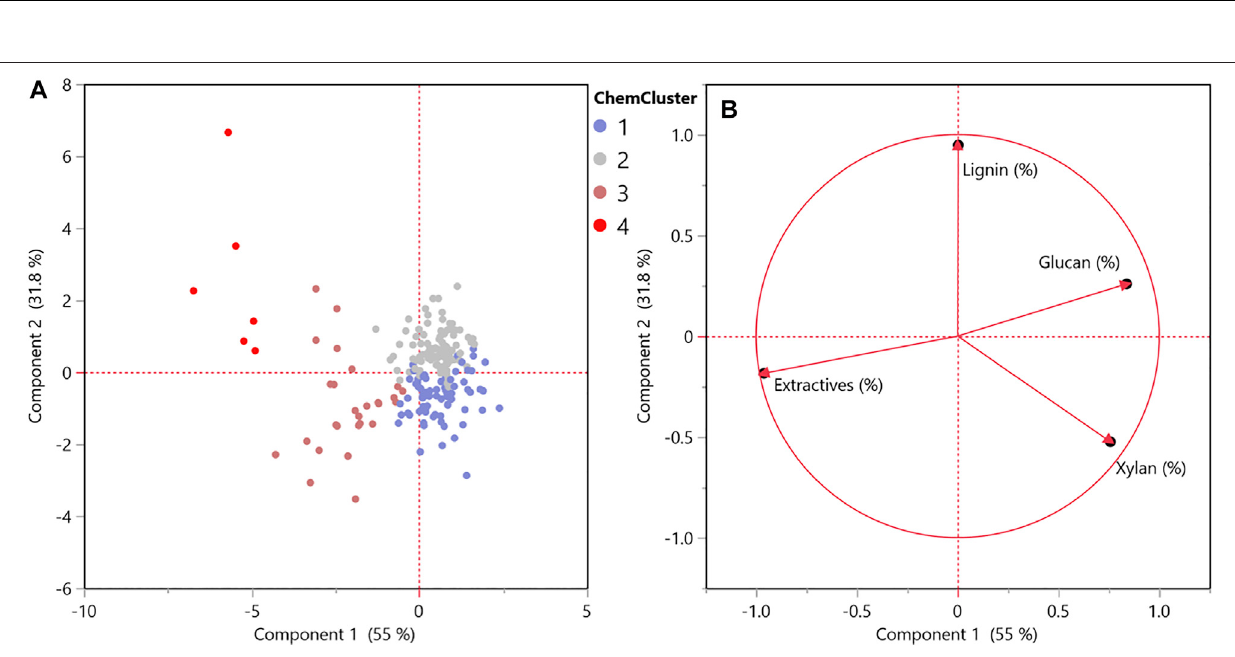
Frontiers in Energy Research |